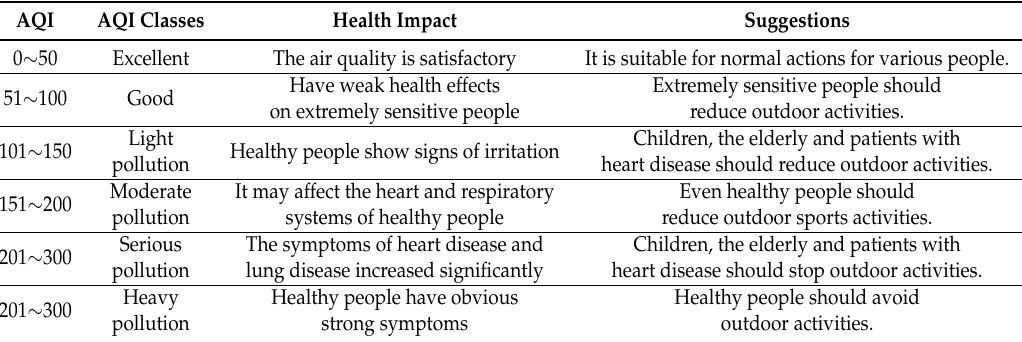
Table 1. The AQI index and related information in